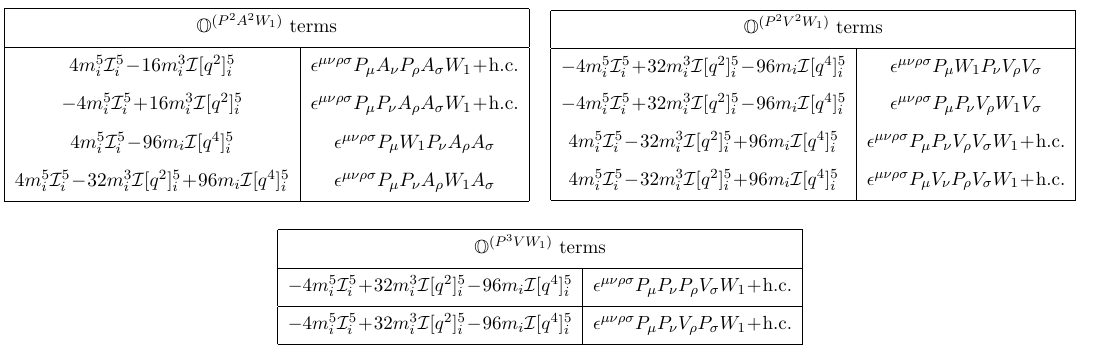
Table 8 . Subset operator structures in the degenerate fermionic UOLEA involving the pseu- doscalar, vector and axial-vector structures. This subset will be used in the various examples we present in section